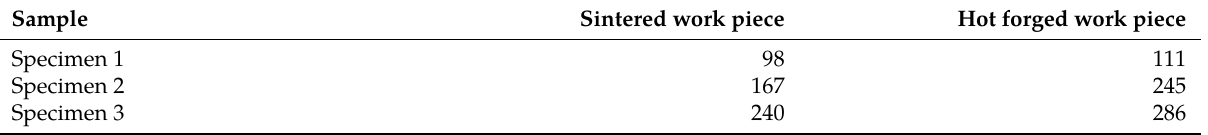
Table 4: Micro-Vickers hardness test result.